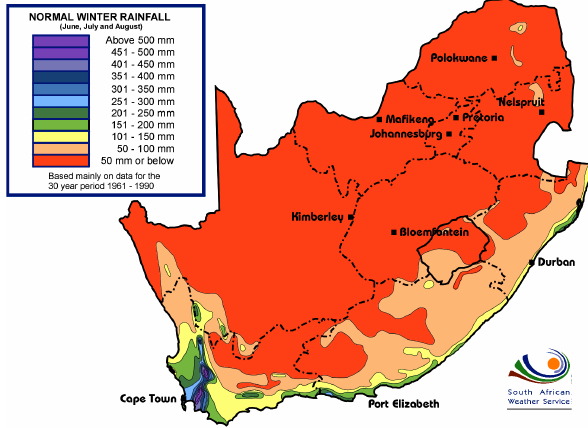
Fig. 2. Normal winter rainfall for South Africa (after Kruger, 2007).